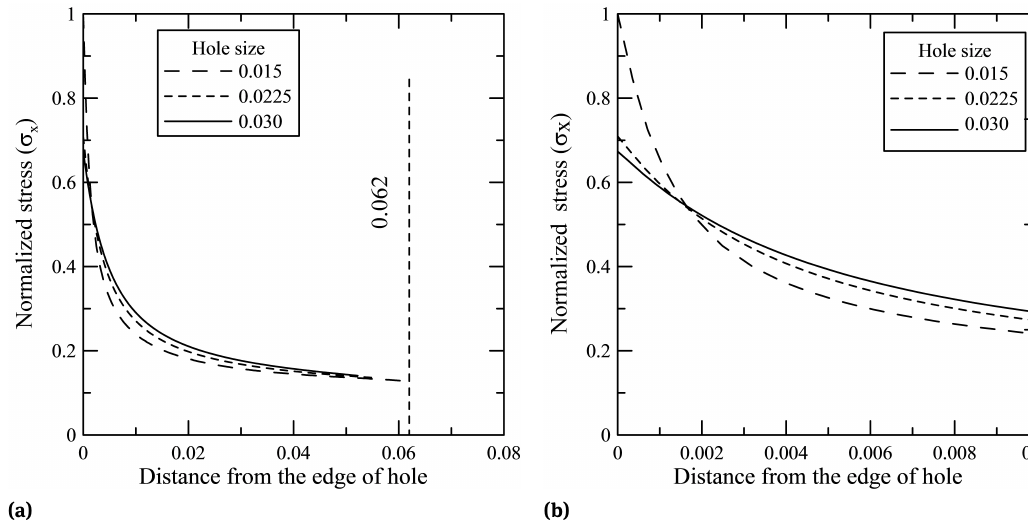
Figure 8: (a) Stress distribution ( 𝜎 𝑥 ) around hole and (b) zoomed view of the stress distribution ( 𝜎 𝑥 ) near the vicinity of hole